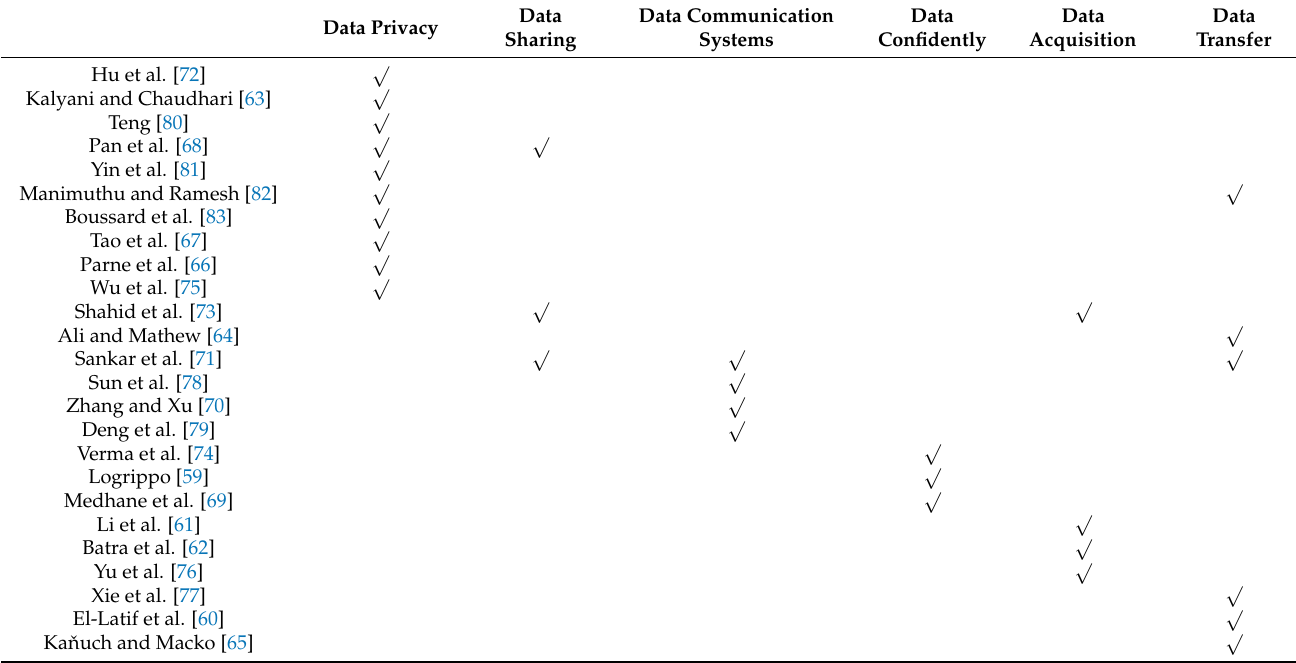
Table 3. Classification of various research based on the context of data